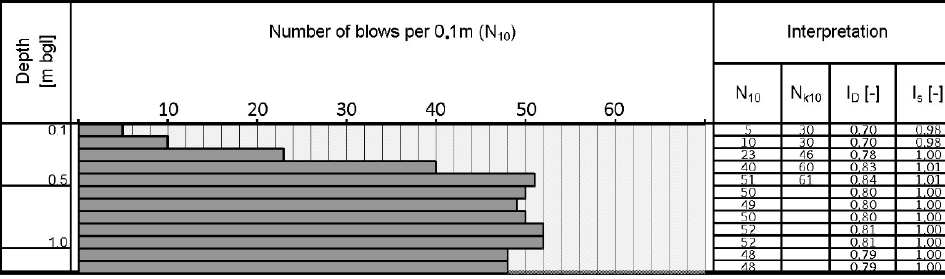
Figure 13. Dynamic probe profile.